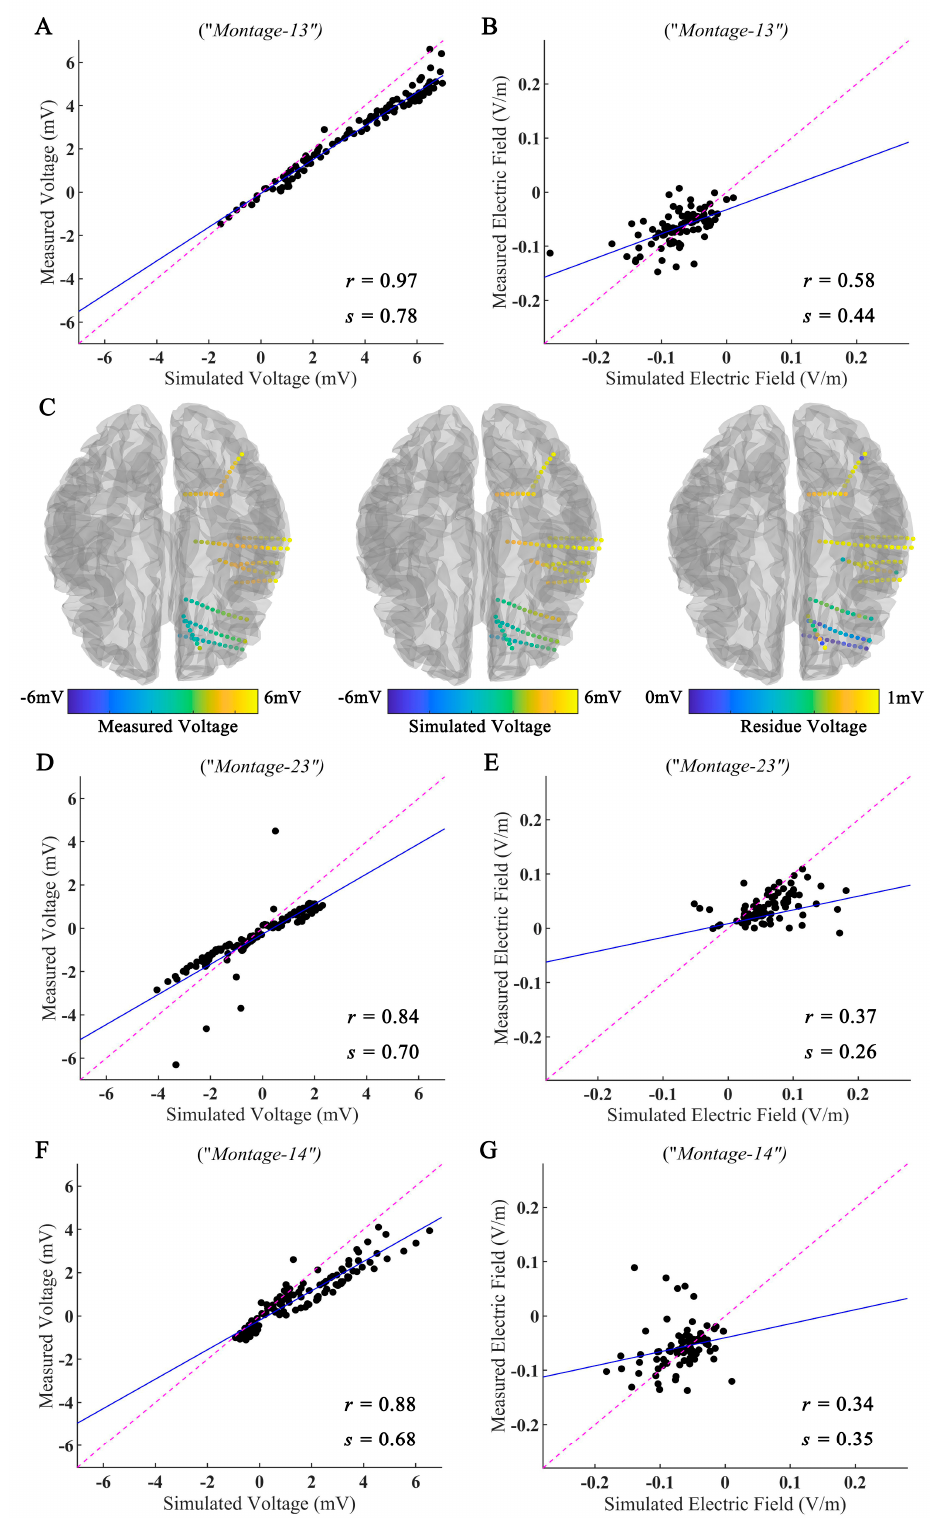
Figure 4. Measured and simulated electric fields of tES. ( A , B ) The measured voltages and projected electric fields with simulated values for Montage-13 . ( C ) The spatial electric potential distributions from recorded and simulated voltages for Montage-13 . ( D – G ) Measured and simulated results for Montage-23 and Montage-14 . Points falling on the magenta line represent perfect prediction (slope s = 1). The blue line represents the fitting line.